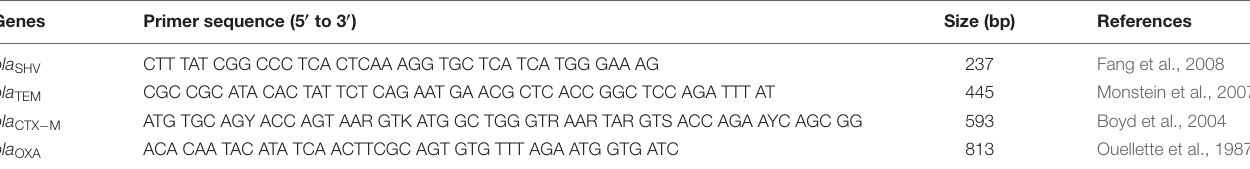
TABLE 1 | Primers used for detection of different β -lactamase genes in the multiplex PCR. Genes Primer sequence (5 (cid:48) to 3 (cid:48)